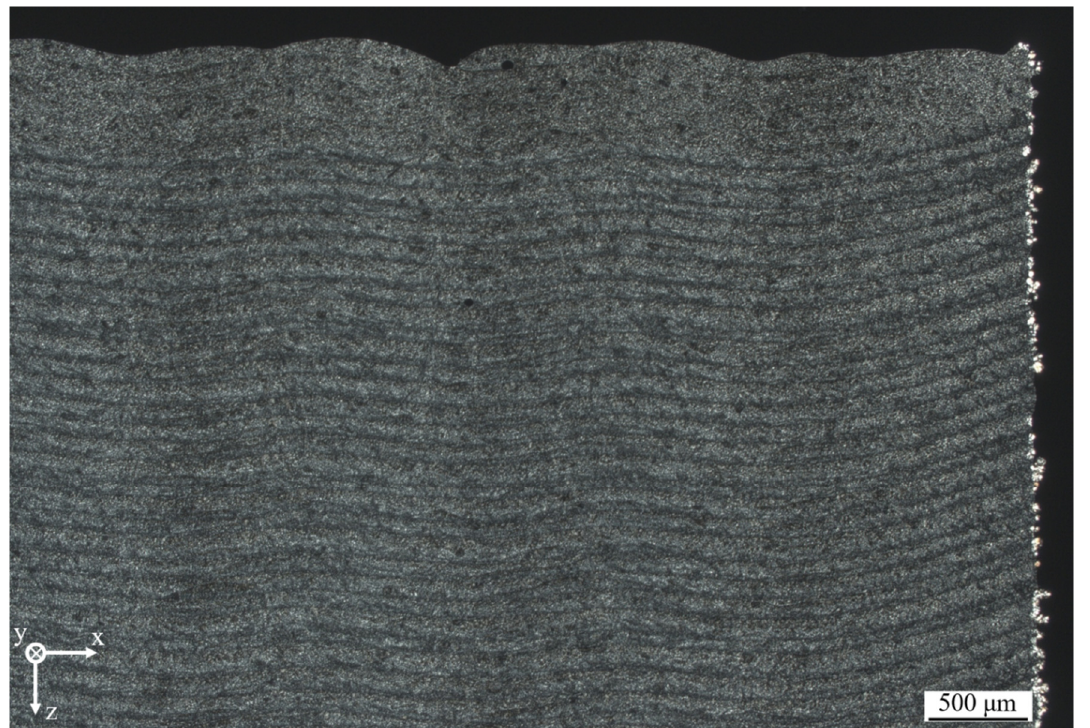
Figure 9. Polarization micrograph of a cubic specimen manufactured at non-isothermal conditions, d thin-section = 10 μ m.